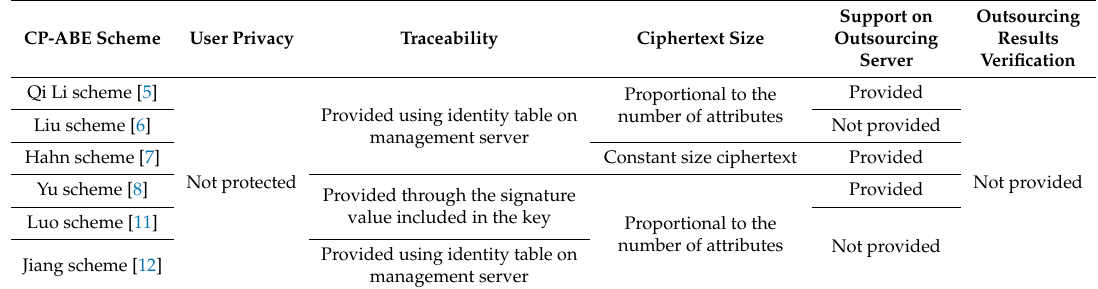
Table 1. Comparison of CP-ABE schemes provided for